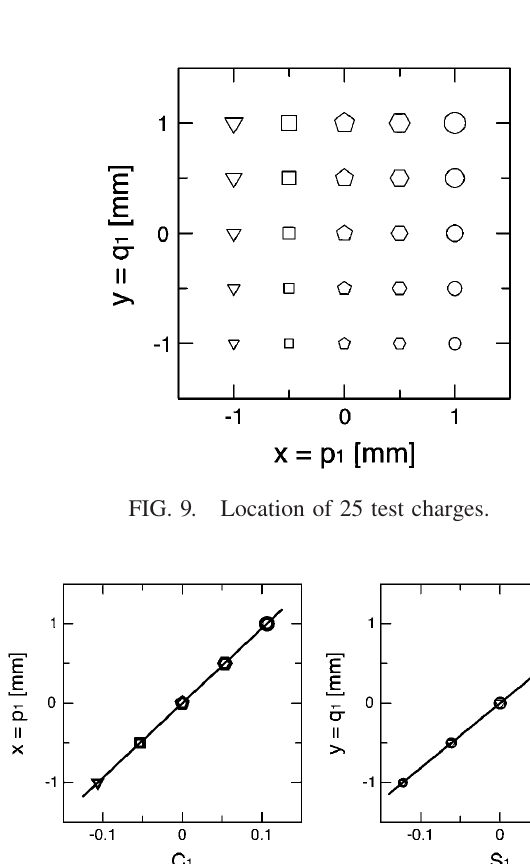
and C , q and S of the nu- 1 1 1 1